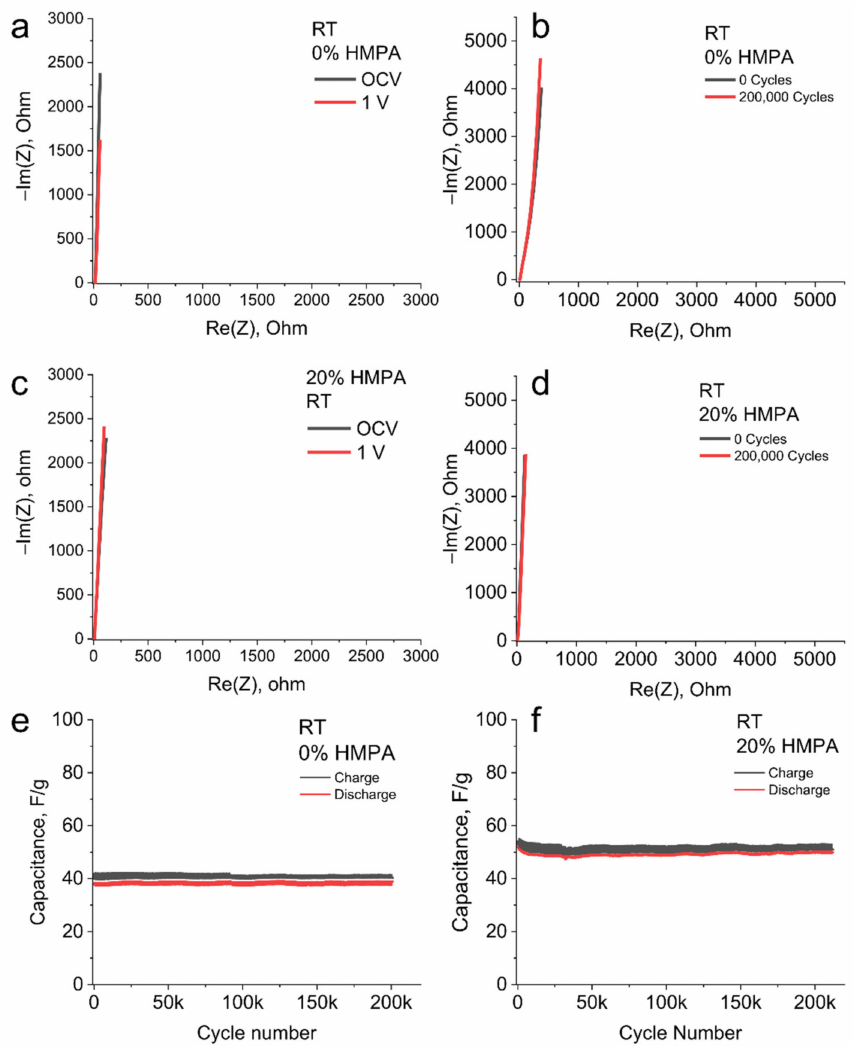
Figure 2. Nyquist plot without ( a ) and with HMPA ( b ) at room temperature. EIS measurements taken during galvanostatic cycling without ( c ) and with HMPA ( d ). Galvanic cycling capacitance vs. cycling number plots without ( e ) and with ( f )